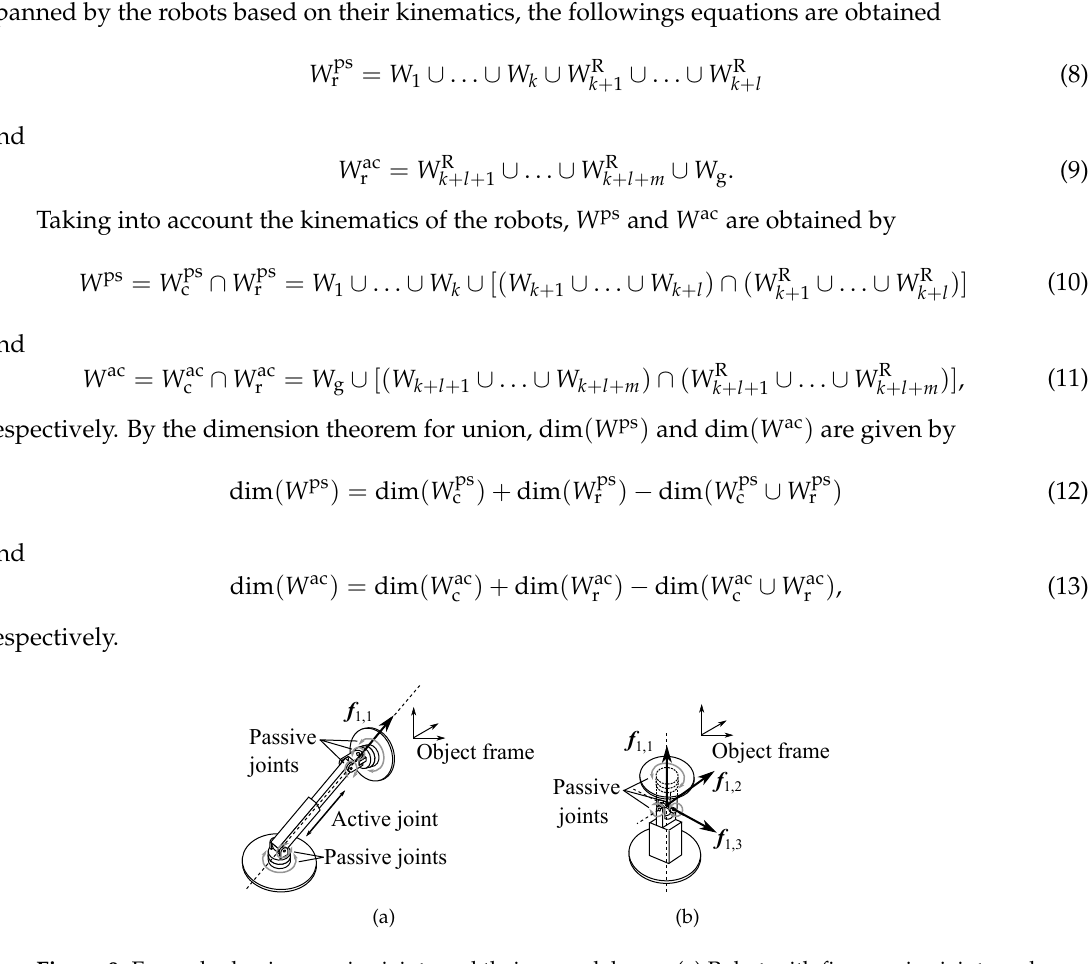
Figure 9. Examples having passive joints and their wrench bases. ( a ) Robot with five passive joints and a linear actuator. ( b ) Robots with three passive